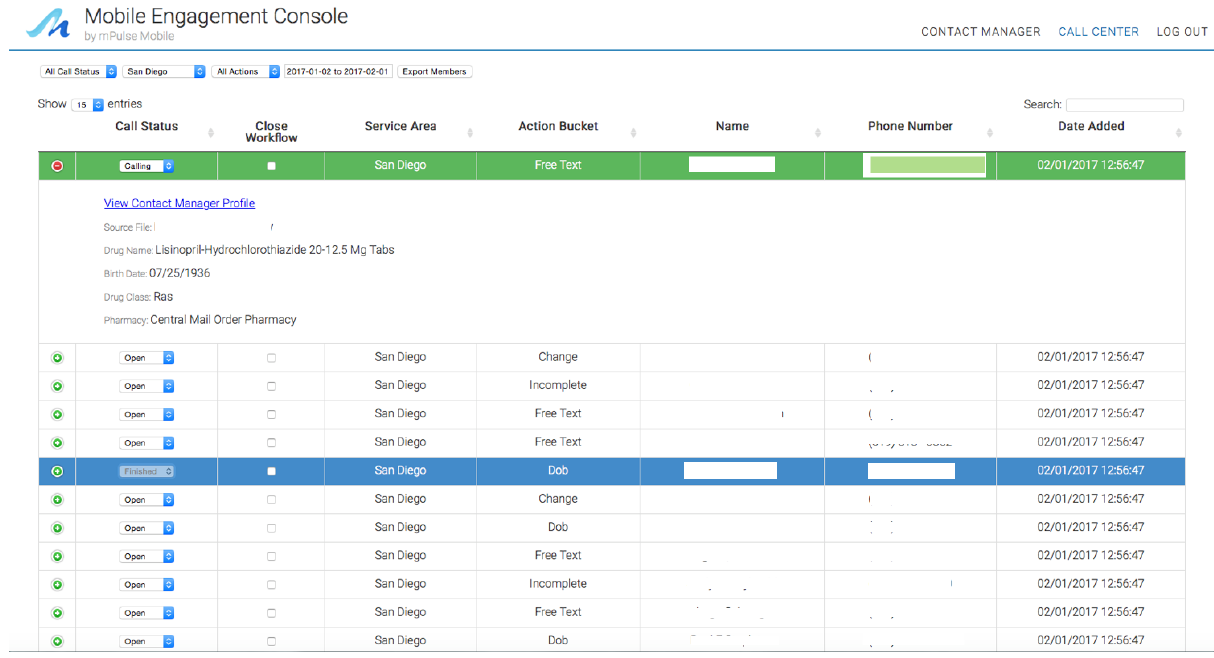
Figure 2. Engagement Console used to process refill requests and address other concerns via